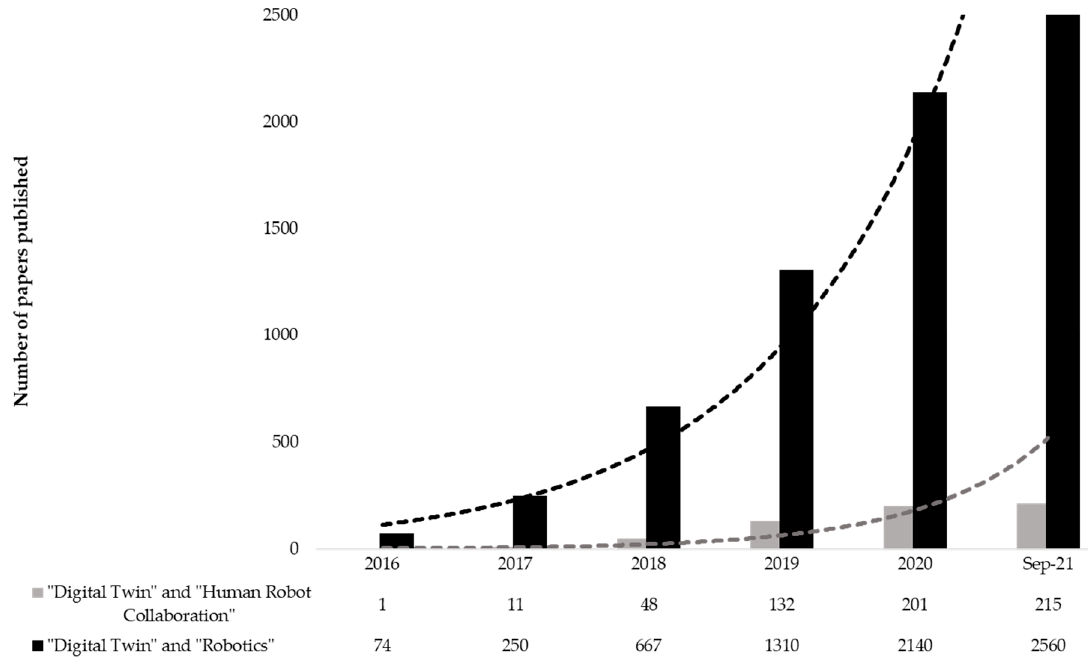
Figure 3. The number of papers found in Google Scholar from the period of 2016—2021. The keyword used for the search is “Digital Twin” and “Robotics” for the data represented in black and the keyword used for the data in grey is “Digital Twin” and “Human Robot Collaboration.” The trend line indicates that interest in these areas has increased significantly since 2016.